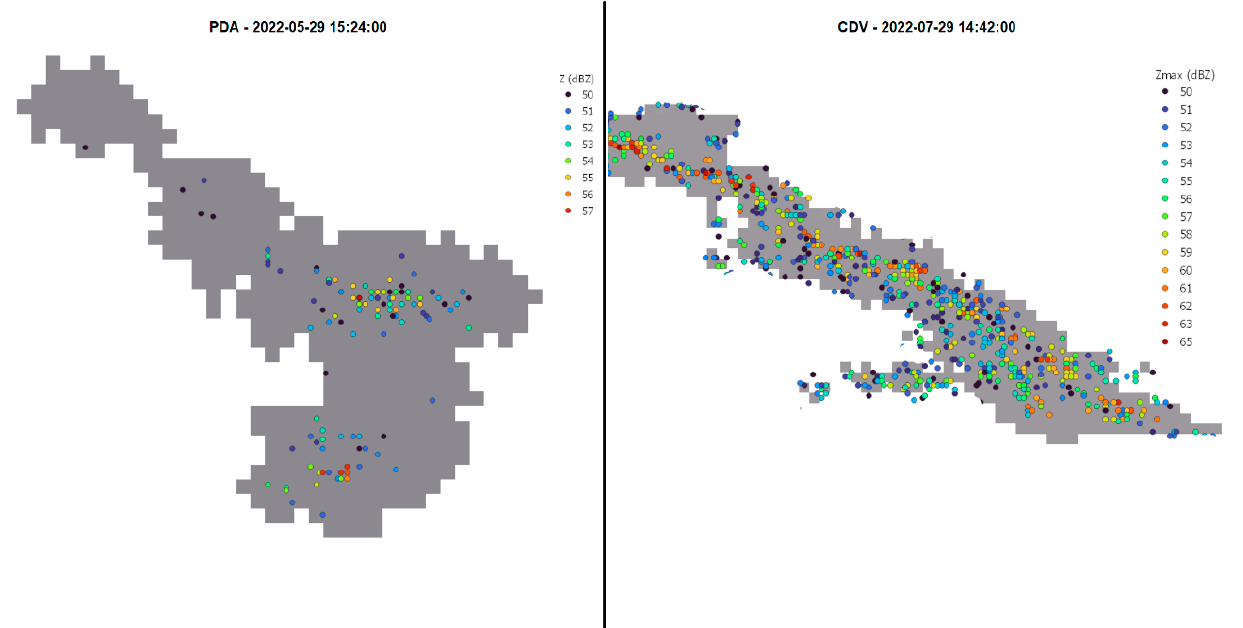
Figure 5. VIL field associated with the hail fall (grey areas) for the same cases shown in Figure 4 (left: PDA radar, 29 May 2022; right: CDV radar, 29 July 2022). The coloured dots show the locations of the regions exceeding the 50 dBZ threshold for each PPI elevation angle and the colour indicates the maximum reflectivity value.